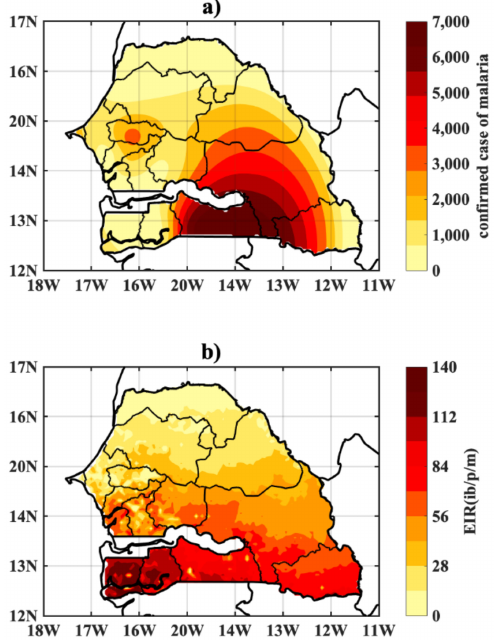
Figure 9. Comparison of the spatial distribution of malaria cases and simulated malaria parameter (EIR in ib/p/m) in Senegal from 2009–2019: malaria case ( a ) and EIR (ib/p/m) ( b ) for